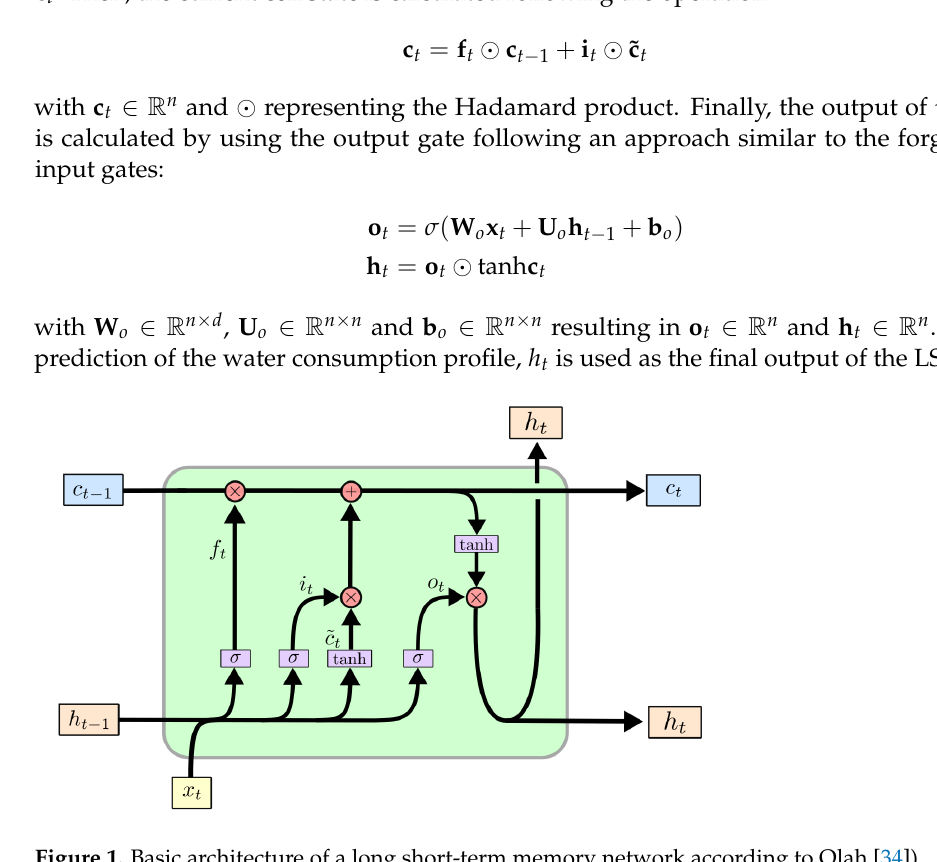
Figure 1. Basic architecture of a long short-term memory network according to Olah